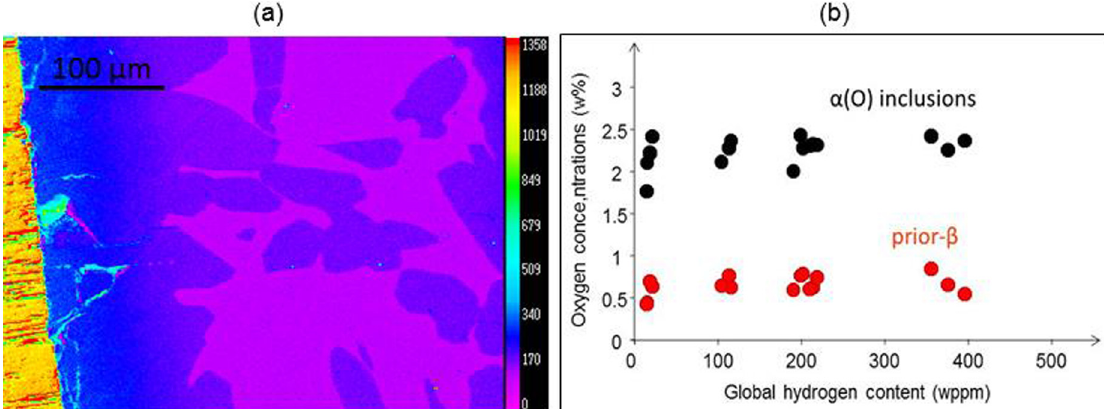
Fig. 5. Oxygen measurements obtained by EPMA of Zircaloy-4 after oxidation at 1200 ° C. (a) Maps in the wall cladding the intensity counts is plotted as a color scale (H64-3) and (b) oxygen concentrations in each phase.